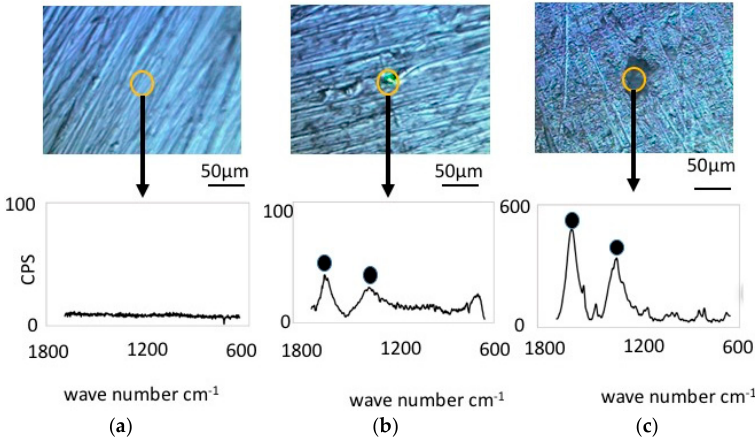
Figure 6. Raman shift peaks and the optical microscopic images for cupronickel specimens. ( a ) Before immersion; ( b ) resident microbiota; ( c ) E-coli .